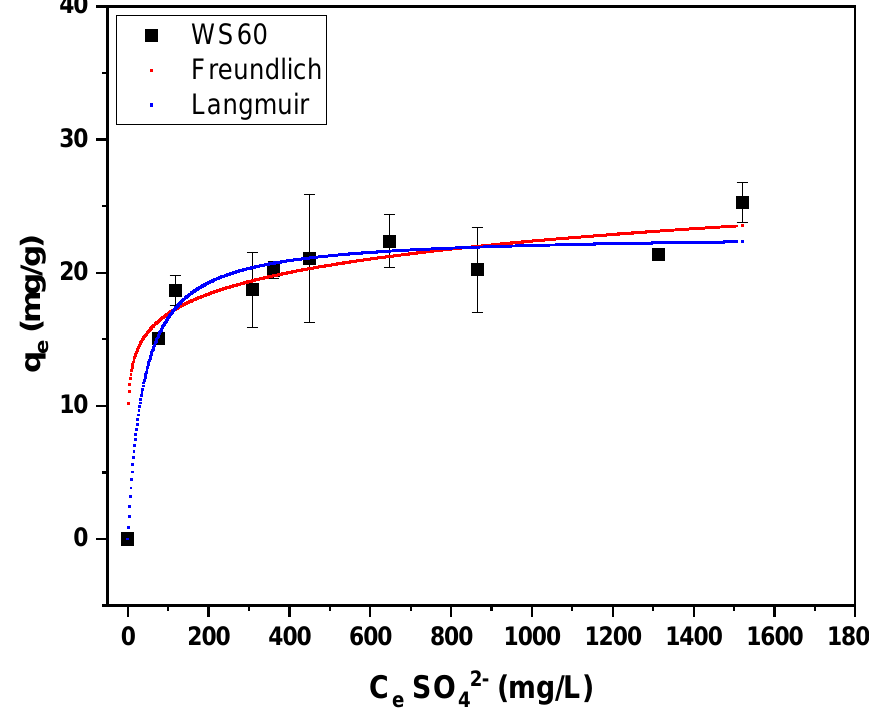
Figure 5. Isotherm adsorption studies of WS60 composite pellet and sodium sulfate at pH 5.2 after 24 h equilibration a 24 h equilibration period.